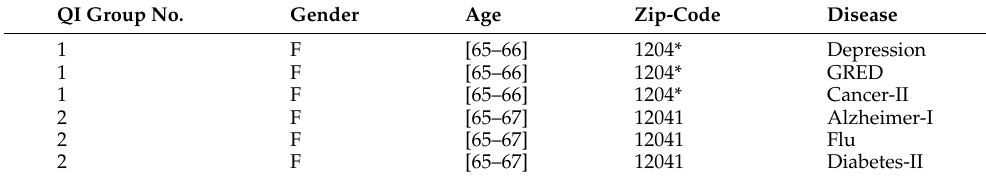
Table 2. Anonymized